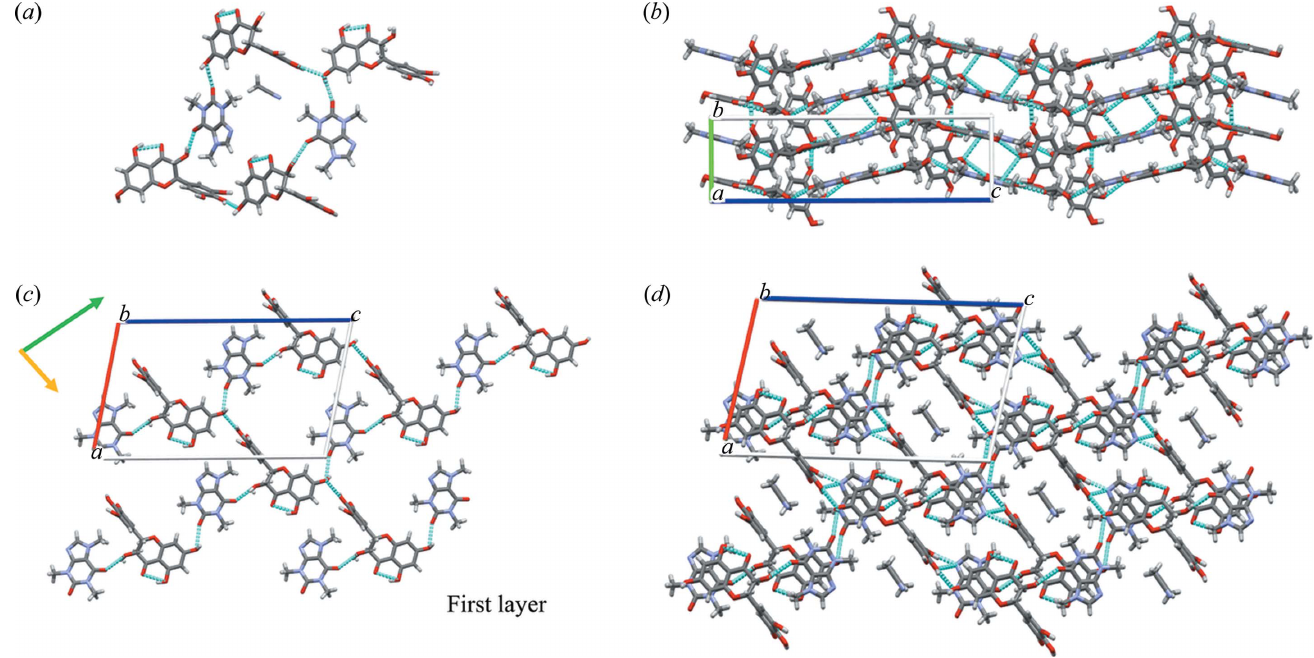
Figure 4 Structure analysis of the Rac -DMY–CAF cocrystal. ( a ) Hydrogen-bonding pattern showing the formation of a channel structure with acetonitrile included. ( b ) 3D molecular packing arrangements between DMYand CAF molecules along the b direction. ( c ) Hydrogen-bonding arrangement and ( d ) 3D molecular packing with an acetonitrile molecule included, viewed along the b